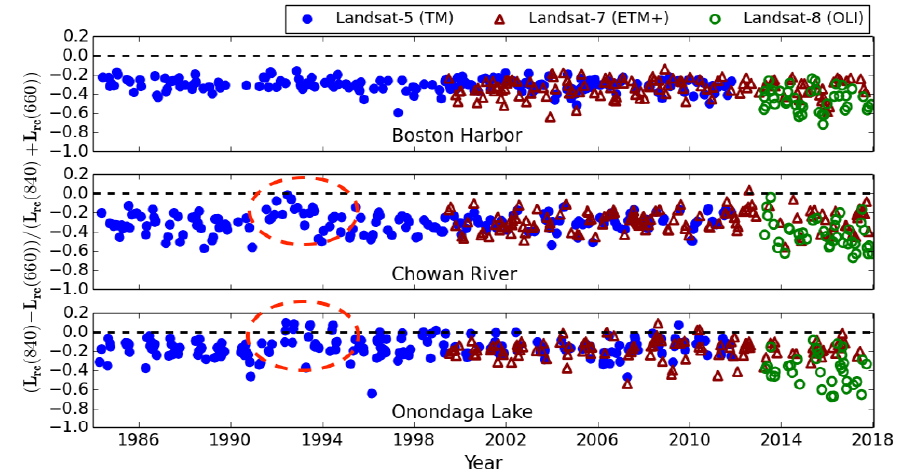
Figure 14. The AE_Ind computed for three sites to analyze presence/absence of adjacency effects (AE). The higher the index, the larger the magnitude of AE is. The Onondaga Lake has the highest and most frequent presence of AE whereas the effect is deemed to be negligible or absent over Boston Harbor. Note that the NIR bands of TM and ETM+ are much wider than that of OLI. This has likely resulted in smaller OLI-derived AE_Ind. The higher-than-normal AE_Ind highlighted with ovals may be due to abnormalities in Landsat-5 orbit in early/mid 90’s